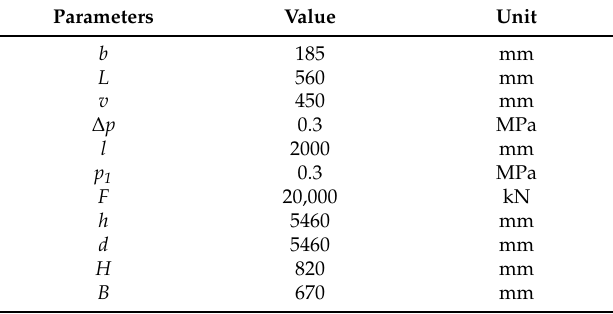
Figure 6. The displacement of the slide in the forming process of the automobile front door panel. Table 1. The data used in the